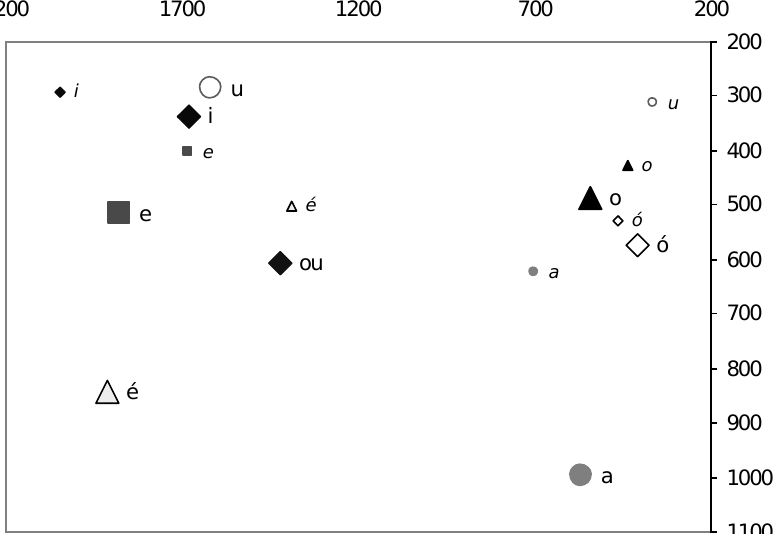
Figure 6: The Vowel Space of Speaker